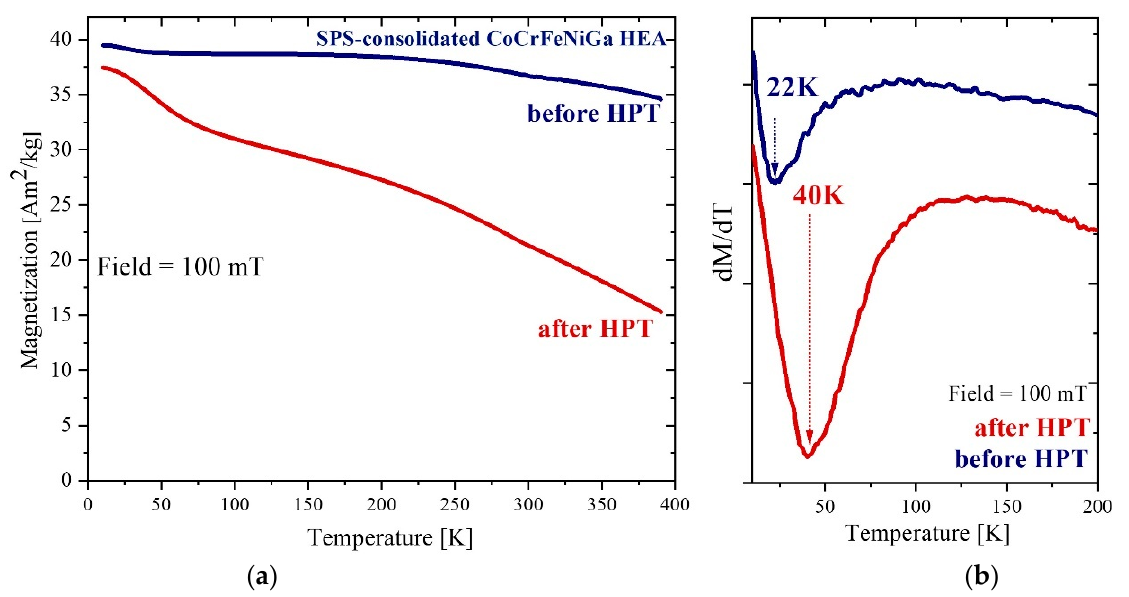
Figure 9. ( a ) Temperature dependence of magnetization measured at 100 mT for SPS-consolidated (blue) and after HPT treatment (red) CoCrFeNiGa HEA. ( b ) Temperature dependences of the slopes of M(T) (dM/dT). The Curie temperature is estimated at the minimum in plot ( b ). Table 3. Magnetic parameters— M s and H c —for CoCrFeNiGa x (x = 0.5, 1.0). HPT processing of the equiatomic CoCrFeNiGa HEA results in a decrease in the sat- uration magnetization by 34% and 55% (see Table 3) at 10 K and 300 K, respectively (Fig- ure 10). The decrease in M s is due to the increased volume fraction of the Ga-depleted fcc phase, which has a lower magnetization (Figure 8a) compared to the bcc Ga-enriched phase [17].